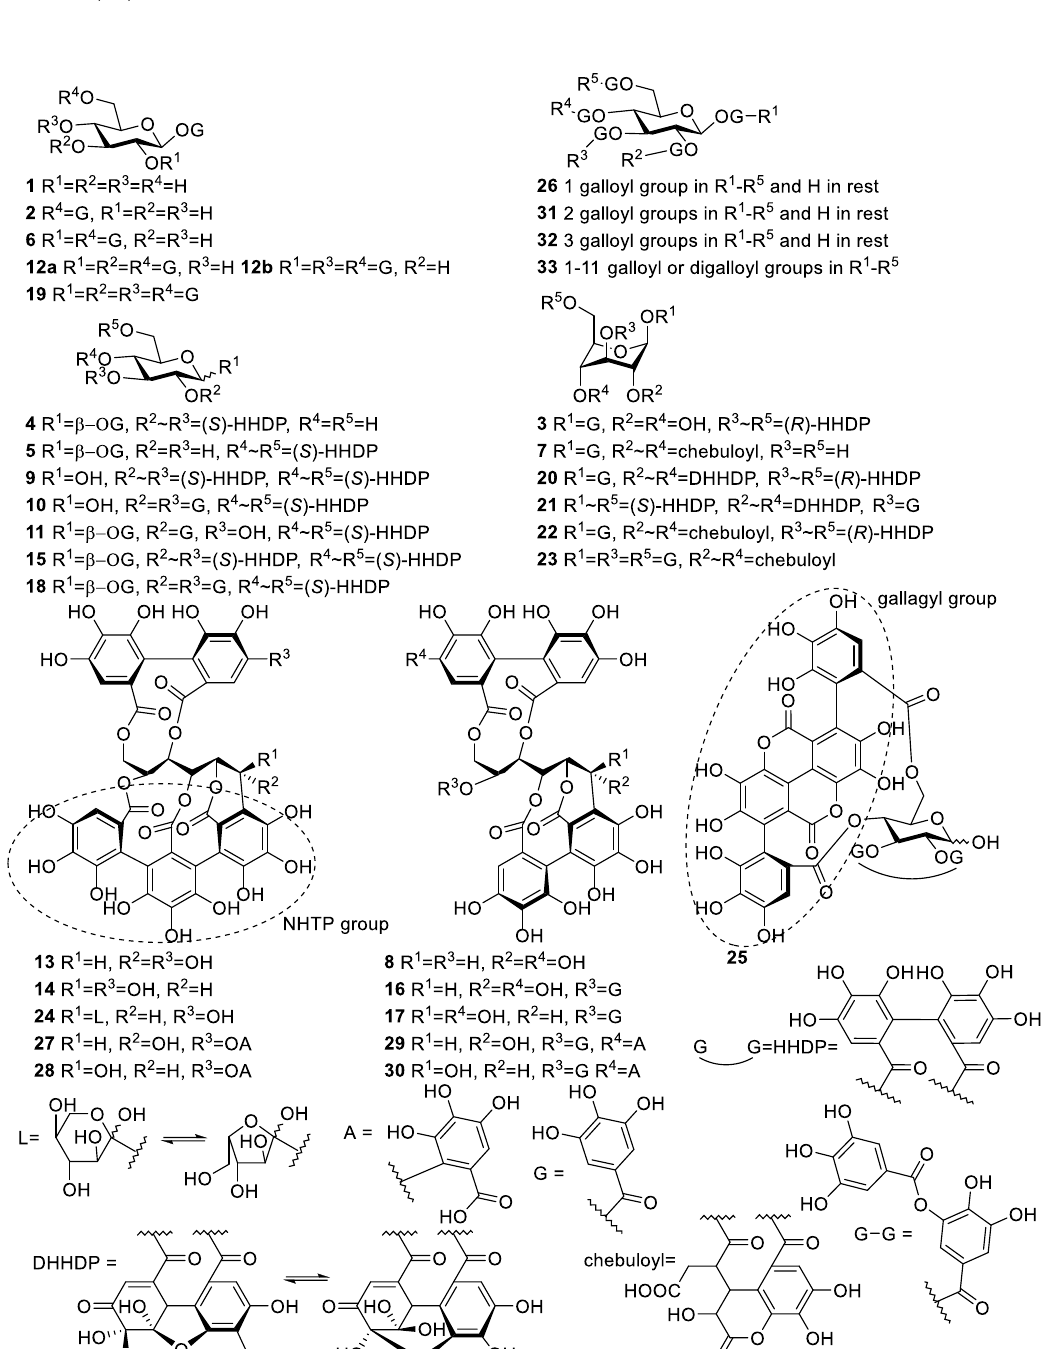
Figure 1. Chemical structures of monomeric hydrolysable tannins used in the study. DHHDP = dehydrohexahydroxydiphenoyl, A = gallic acid, G = galloyl, HHDP = hexahydroxydiphenoyl, L = lyxose, NHTP = nonahydroxytriphenoyl. 1 1- O -galloyl-β- D -glucose, 2 1,6-di- O -galloyl-β- D -glucose, 3 corilagin, 4 isostrictinin, 5 strictinin, 6 1,2,6-tri- O -galloyl-β- D -glucose, 7 chebulanin, 8 casuariin, 9 pedunculagin, 10 tellimagrandin I, 11 1,2,-di- O -galloyl-4,6-HHDP-β- D -glucose, 12a 1,2,3,6-tetra- O -galloyl-β- D -glucose, 12b 1,2,4,6-tetra- O -galloyl-β- D -glucose, 13 castalagin, 14 vescalagin, 15 casuarictin, 16 casuarinin, 17 , stachyurin, 18 tellimagrandin II, 19 1,2,3,4,6-penta- O -galloyl-β- D -glucose, 20 geraniin, 21 carpinusin, 22 chebulagic acid, 23 chebulinic acid, 24 grandinin, 25 punicalagin, 26 hexagalloylglucose, 27 castavaloninic acid, 28 vescavaloninic acid, 29 hippophaenin B, 30 hippophaenin C, 31 heptagalloylglucose, 32 octagalloylglucose, 33 gallotannin mixture. Actual galloylation location of compounds 26 , 31 , 32 and 33 were not confirmed.